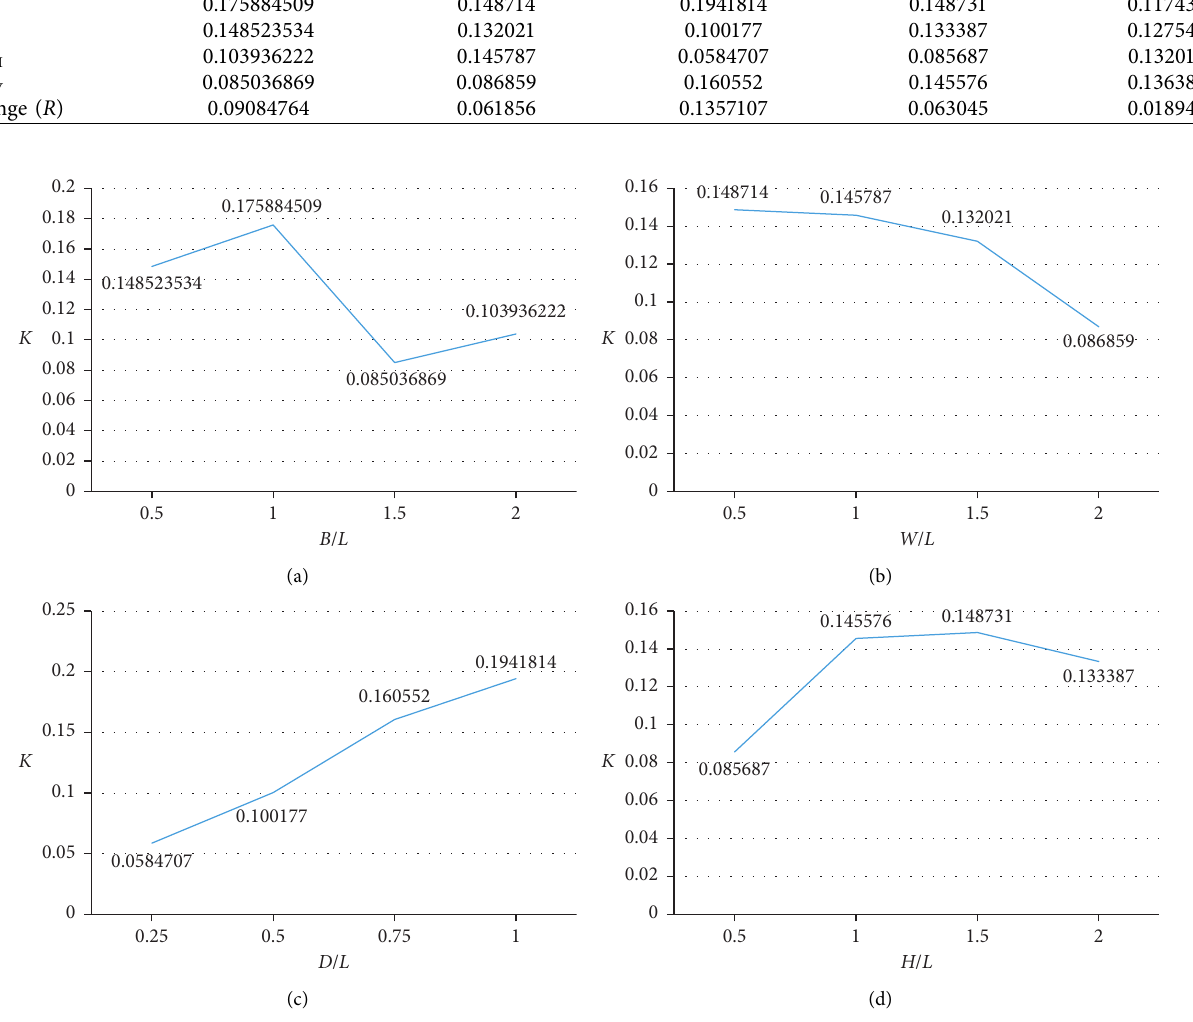
Figure 6: Changes of K value with the factor levels in the orthogonal experiment. (a) Changes of K value with different B / L levels. (b) Changes of K value with different W / L levels. (c) Changes of K value with different D / L levels. (d) Changes of K value with different H / L levels. Table 8: Variance analysis of the orthogonal experiment.